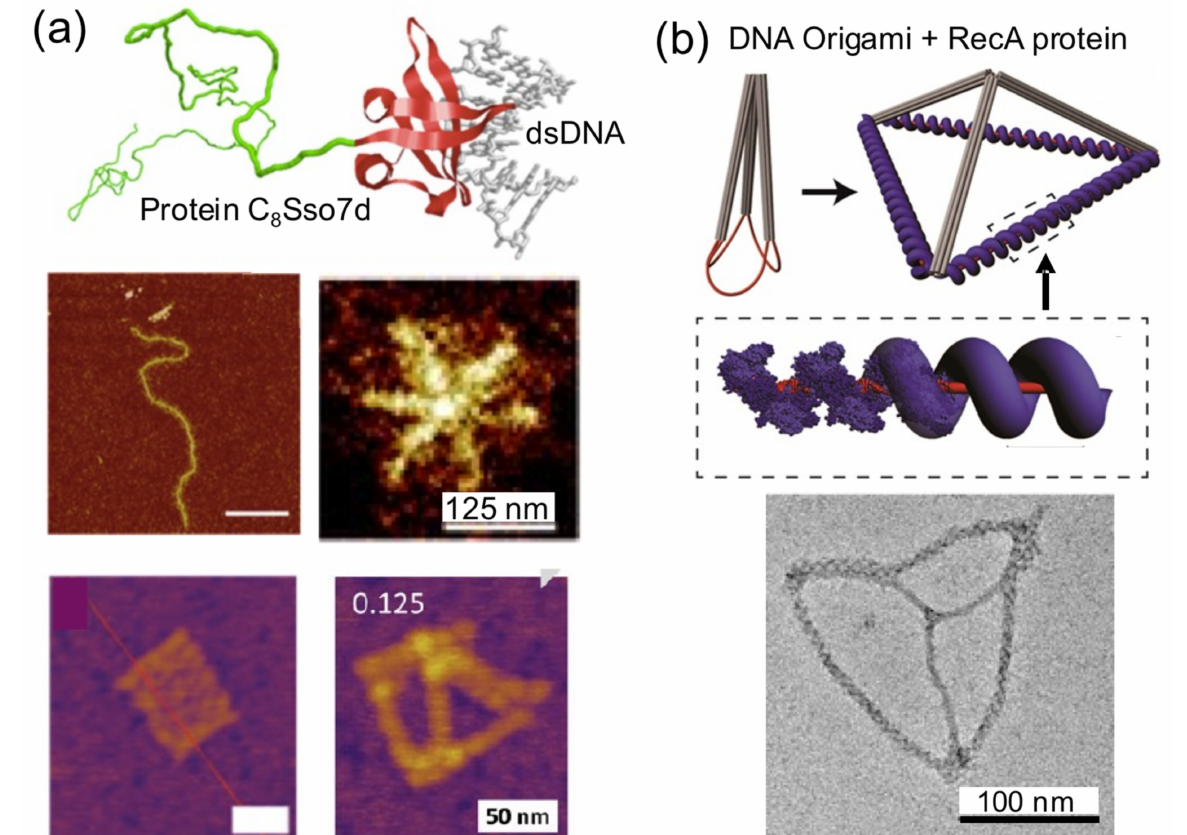
Figure 8. Coating and rigidizing DNA with proteins. ( a ) Diblock protein C 8 Sso7d is able to coat and rigidize dsDNA molecules into branched DNA to form hybrid nanostars and DNA origamis. AFM images (bottom). Scale bars: 500 nm (middle left), 125 nm (middle right), and 50 nm (bottom). Top, middle, and bottom left images adapted from [31], with permission from American Chemical Society, 2017. Bottom right image adapted from [45], with permission from American Chemical Society, 2017. Middle right image adapted from [18], with permission from Royal Society of Chemistry, 2019. ( b ) RecA protein self-assembles on ssDNA stretches incorporated into a DNA origami rigidizing those parts and forming a tetrahedral hybrid nanostructure. TEM image (bottom). Adapted from [50], with permission from American Chemical Society,